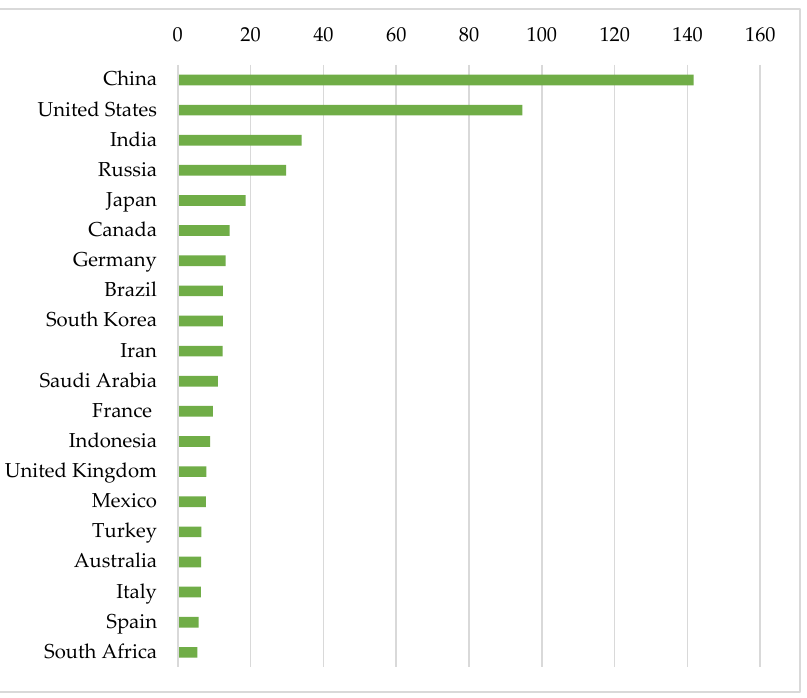
Figure 1. Leading countries in primary energy consumption worldwide in 2019 (in exajoules). Resource: Statista, 2020 [75].